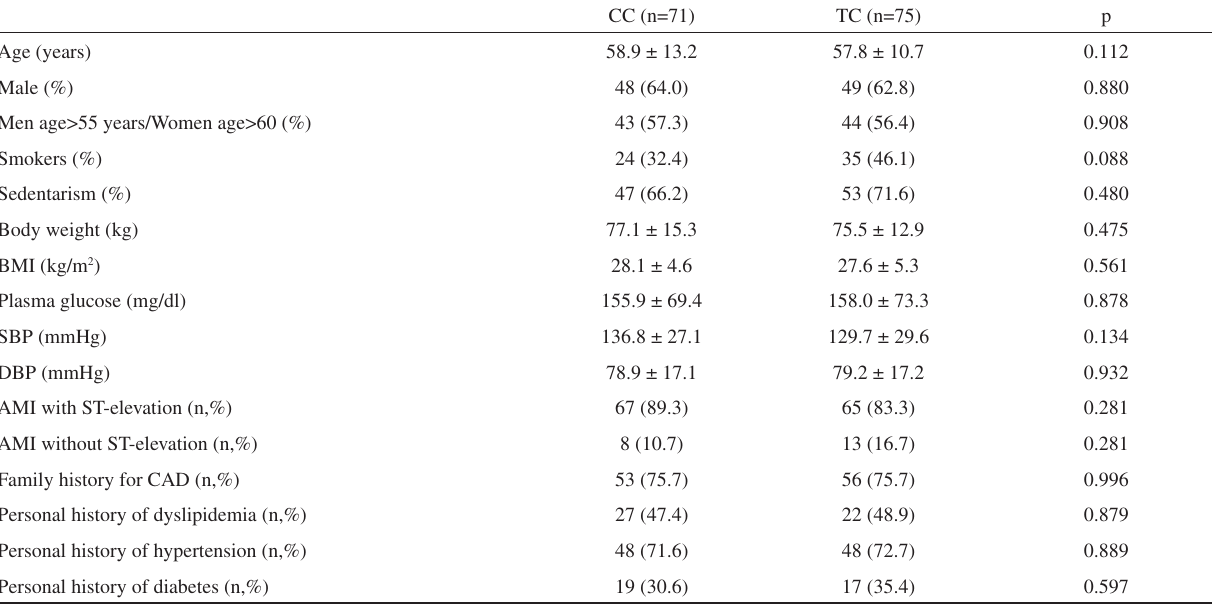
Table 1 - Baseline characteristics of individuals studied after diagnosis of their first acute myocardial infarction